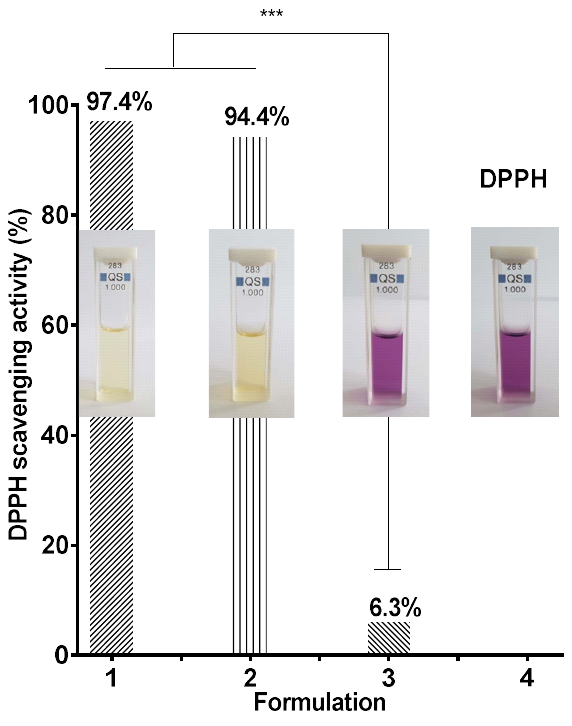
Figure 7. Antioxidant activity of: 1- ethanol solution of quercetin, 2- CA / PEG / QUE mat, and 3 -CA / PEG mat. *** p < 0.001. Photos of the corresponding solutions are shown.